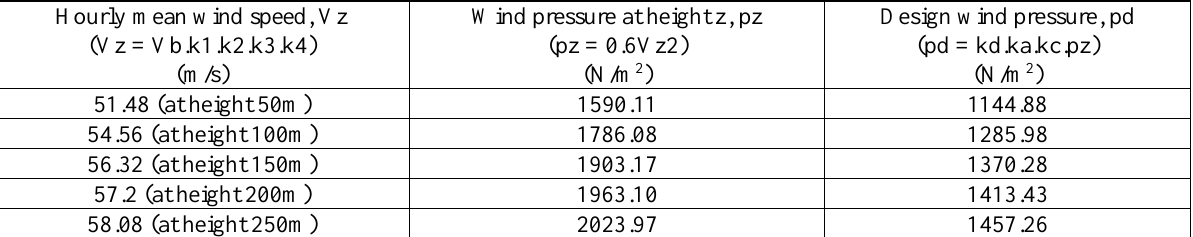
Design pressure at various heights of the